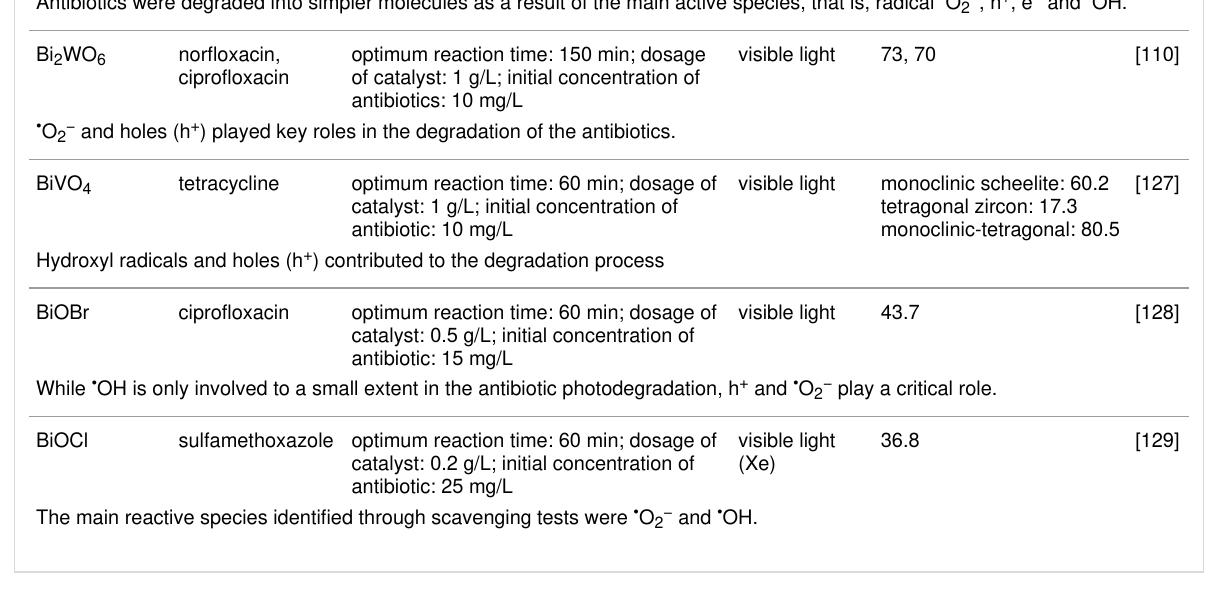
Table 5: Undoped Bi-based nanostructured photocatalysts for remediation of dye pollution.